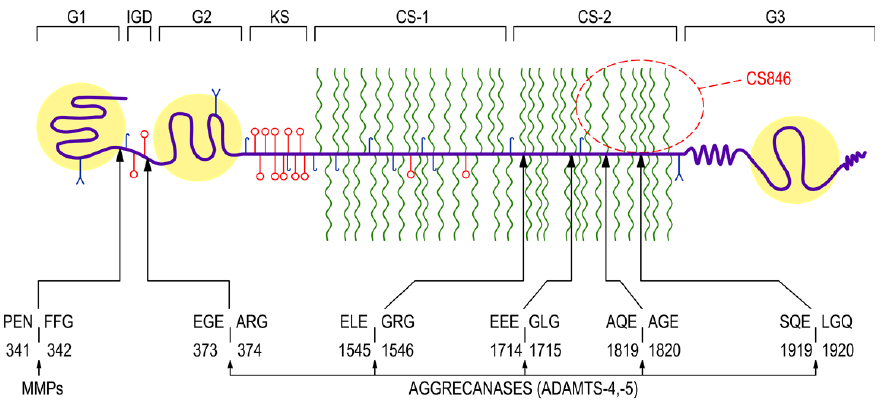
Figure 1. Schematic presentation of the large proteoglycan aggrecan with cleavage sites of aggrecanases and matrix metalloproteinases. Aggrecan core protein is composed of three globular regions termed G1, G2 and G3 and two extended regions forming the interglobular region located between G1 and G2 and the main region of glycosaminoglycan (GAG) attachment. The GAG-attachment region is subdivided into the keratan sulfate-rich domain and two adjacent chondroitin sulfate-rich domains (CS-1 and CS-2). The localization of aggrecan chondroitin sulfate 846 epitope is also shown, which is expressed only on the largest, newly synthesized aggrecan molecules. Amino acid sequences are written in single-letter code. ADAMTS-4 and ADAMTS-5, disintegrin and metalloproteinase with thrombospondin motifs 4 and 5; CS-1 and CS-2, chondroitin sulfate-rich domain 1 and 2; CS846, chondroitin sulfate 846 epitope; G1, G2 and G3, globular regions 1, 2 and 3; IGD, interglobular domain; KS, keratan sulfate-rich domain; MMPs, matrix metalloproteinases.